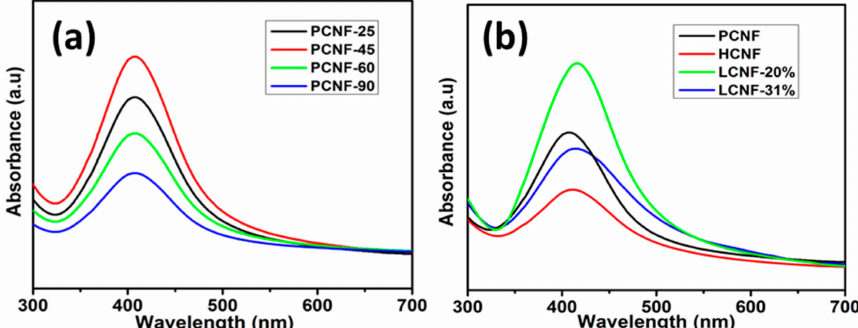
Figure 1. UV-visible absorption spectra of AgNPs adsorbed: ( a ) on PCNF at di ff erent temperatures; ( b ) on di ff erent CNFs with di ff erent chemical compositions at 45 ◦